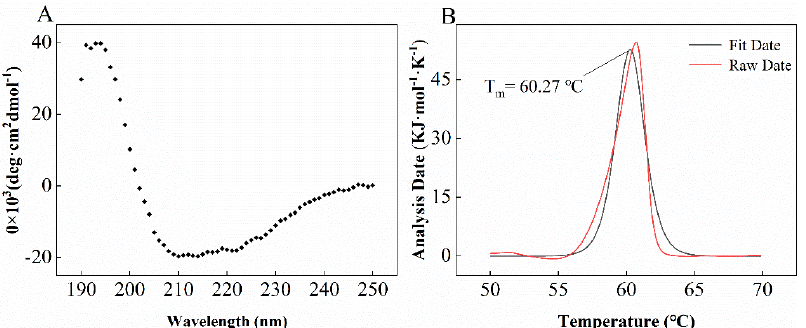
Figure 3. CD and nano-DSC assays. ( A ) The secondary structure of purified LUCA–DmpA con- tained α -helix (35.23 ± 0.06%), β -sheet (11.06 ± 0.06%), β -turn (23.67 ± 0.06%) and random coil (32.03 ± 0.06%). ( B ) Thermal denaturation midpoint temperature ( T m ) analysis of LUCA–DmpA was subjected to nano-DSC analysis; the Tm and ∆ H of LUCA–DmpA were 60.27 ± 1.24 ◦ C and 1306 ± 26.73 kJ · mol − 1 , respectively.